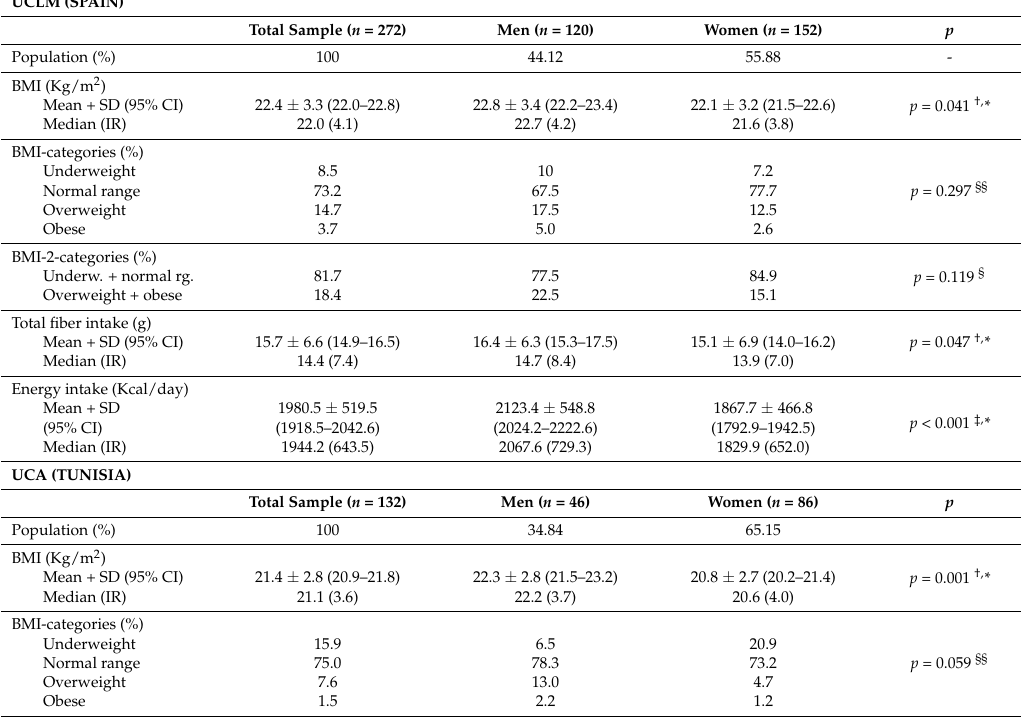
Table 2. Body mass index (BMI), fiber intake and energy intake characteristics of the sample by